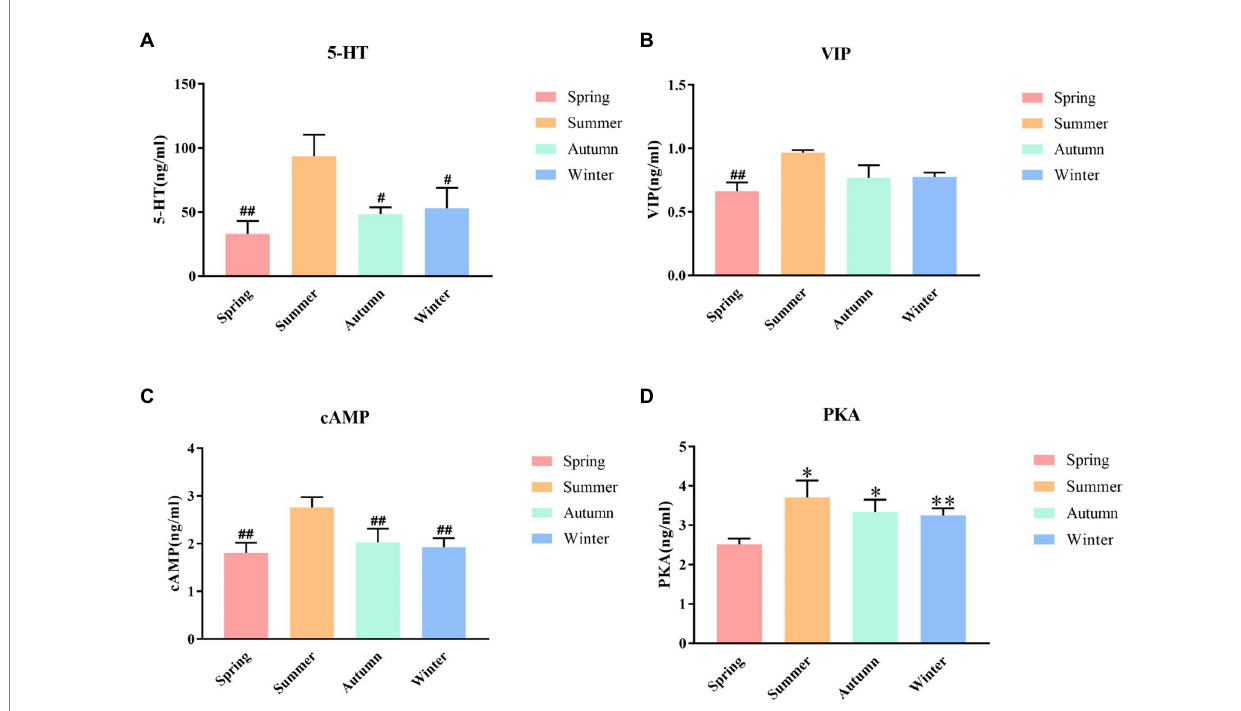
FIGURE 5 . (A) 5-HT content of colon. (B) VIP content of colon. (C) cAMP content of colon. (D) PKA content of colon. * p < 0.05 compared with the spring group; ** P <0.01 compared with the spring group; # P <0.05 compared with the summer group; ## P <0.01 compared with the summer